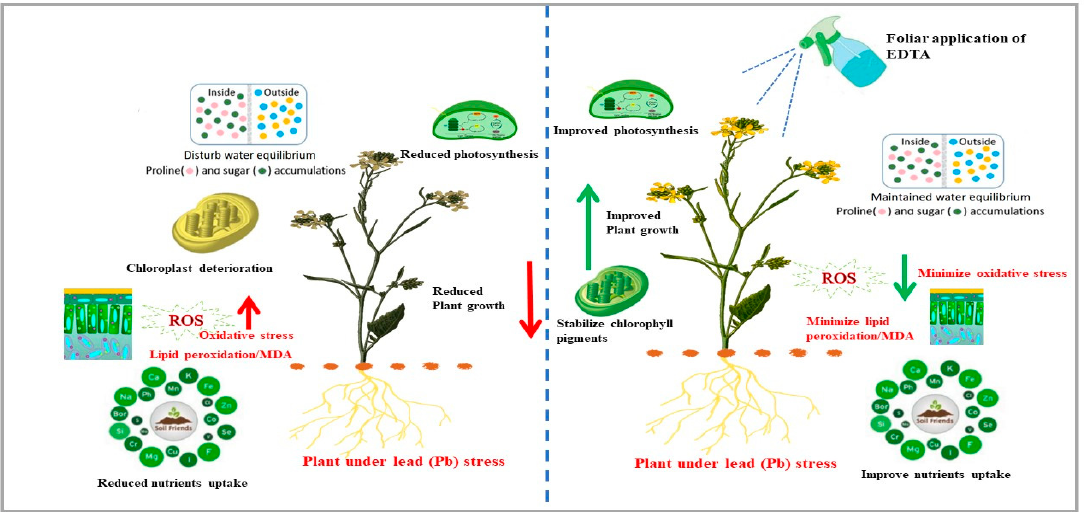
Figure 8. A theoretical scheme represents two different mechanisms of brown mustard plants grown under lead (Pb) contaminated soil with and without foliar application of ethylenediamine tetraacetic acid (EDTA). Pb stress adversely affects the morphological, biological, and physiological charac- teristics of the brown mustard plant, resulting in minimizing the uptake of the essential nutrients, disturbing water equilibrium, enhancing the oxidative stress, and deteriorating the organelles’ struc- tures, i.e., mitochondria and chloroplast, which ultimately reduced the photosynthesis activity and plants growth. The plant cells are not adequately protected by this stress-responsive mechanism, which causes excessive MDA release from reactive oxygen species-damaged cells. The situation can be the exact opposite in the case of brown mustard plants whose leaves have been exposed to the foliar application of EDTA. EDTA induced stomatal closure to prevent evapotranspiration and mediate stress-responsive pathways to lessen cell damage during Pb stress, which helps to enhance and stabilize the chlorophyll pigments and osmolytes accumulation, which results in improved photosynthesis activity, reduced oxidative stress, and ultimately improved the yield of the